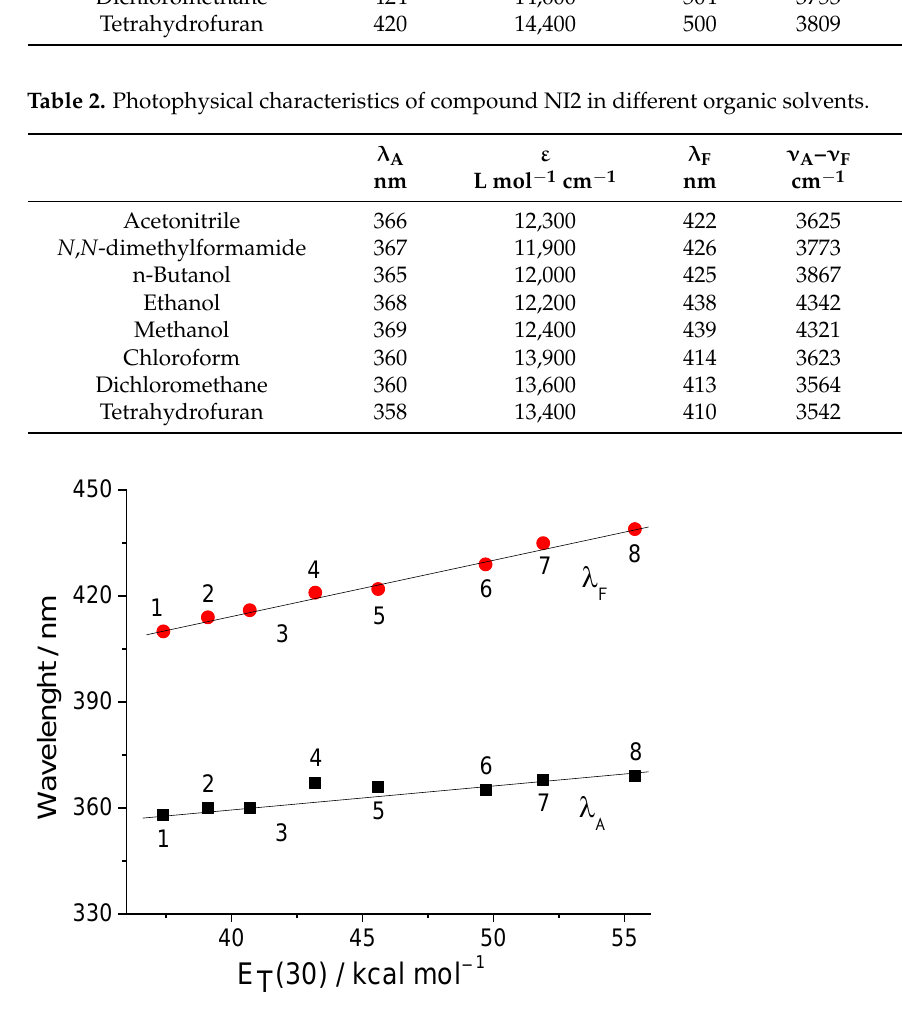
Figure 1. Dependence of absorption (black squares) and fluorescence (red circles) maxima of NI2 on the polarity of organic solvents (E T (30)): (1) tetrahydrofuran, (2) chloroform, (3) dichloromethane, (4) N , N -dimethylformamide, (5) acetonitrile, (6) n -butanol, (7) ethanol, and (8) methanol.